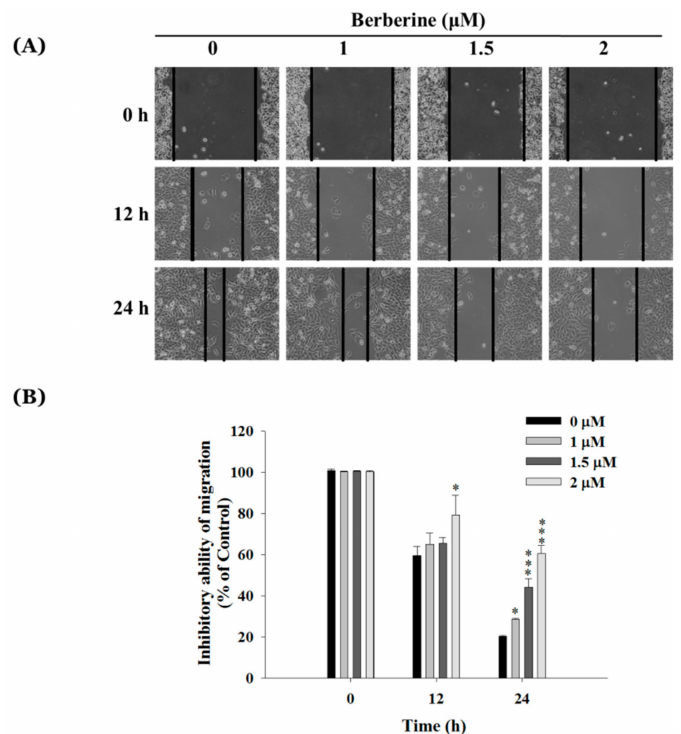
Figure 2. The berberine-affected in vitro wound closure of A375.S2 cells. The cells (2 × 10 5 cells/well) were kept in 12-well plates for 24 h, scratched (wounded), and then incubated with different berberine concentrations (0, 1, 1.5, and 2 µ M) for 12 and 24 h. The relative wound closures were photographed using phase contrast microscopy ( A ) and the percentage of the inhibitory ability of migration was calculated ( B ) as described in Materials and Methods. * p < 0.05, *** p < 0.001, significant difference between berberine-treated groups and the control as analyzed by one-way ANOVA analysis of variance.